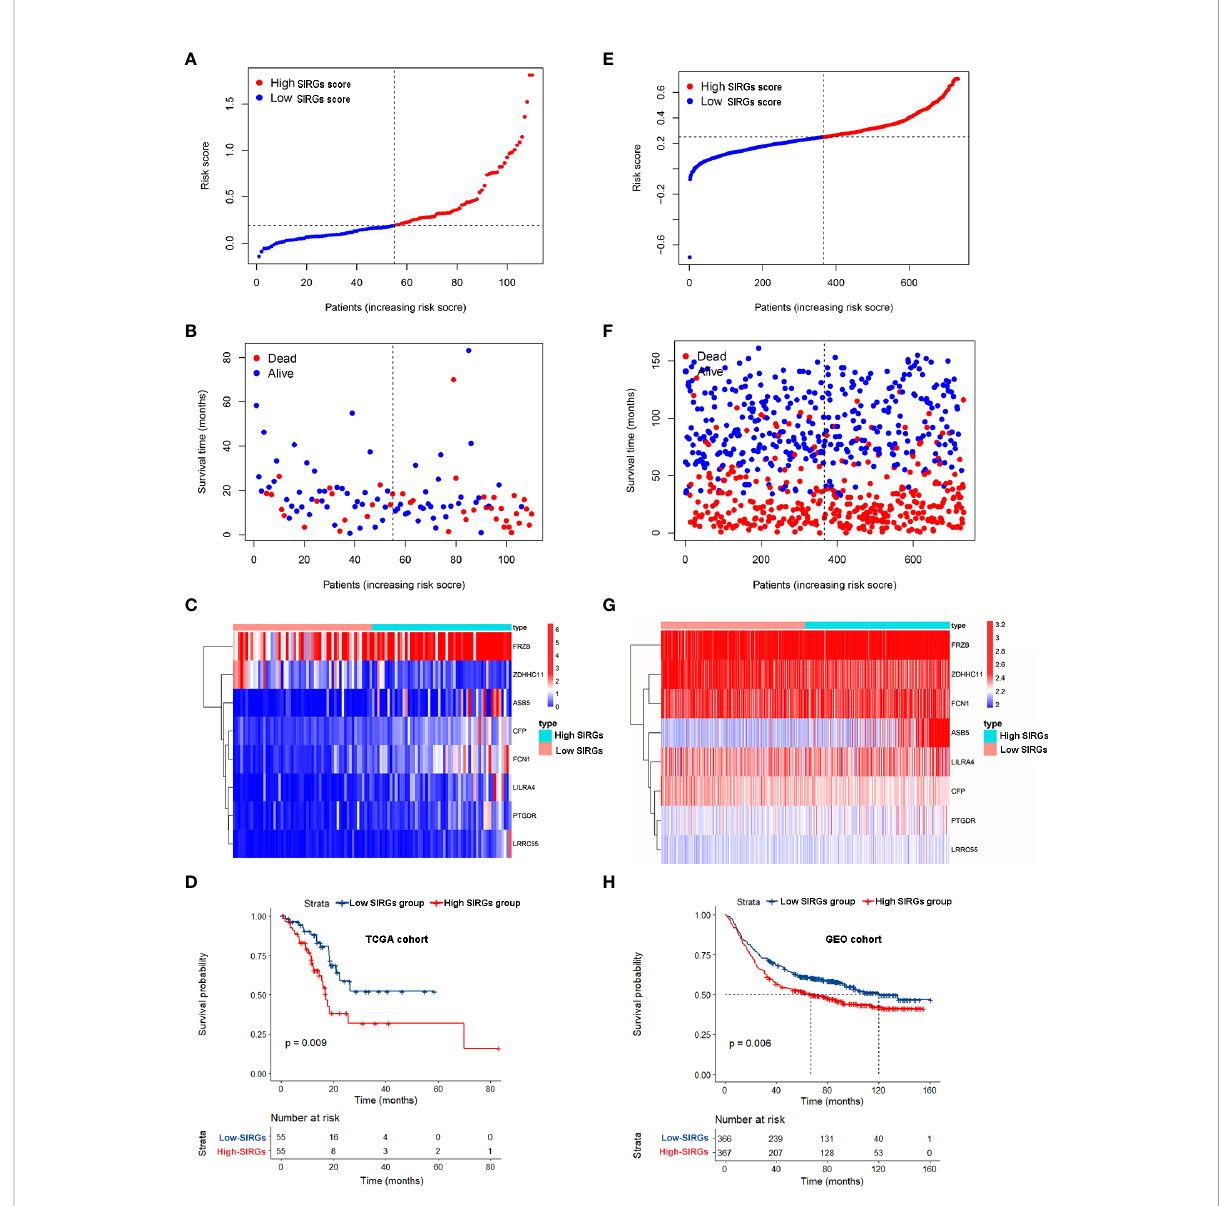
FIGURE 3 Survival analysis of SIRGs score in TCGA cohort and GEO cohort. (A, E) The rank of SIRGs scores; (B, F) The distribution of SIRGs score and overall survival time; (C, G) The heatmap of expression patterns of 8 SIRGs in low- and high-SIRGs score group; (D, H) Survival curves of different SIRGs score